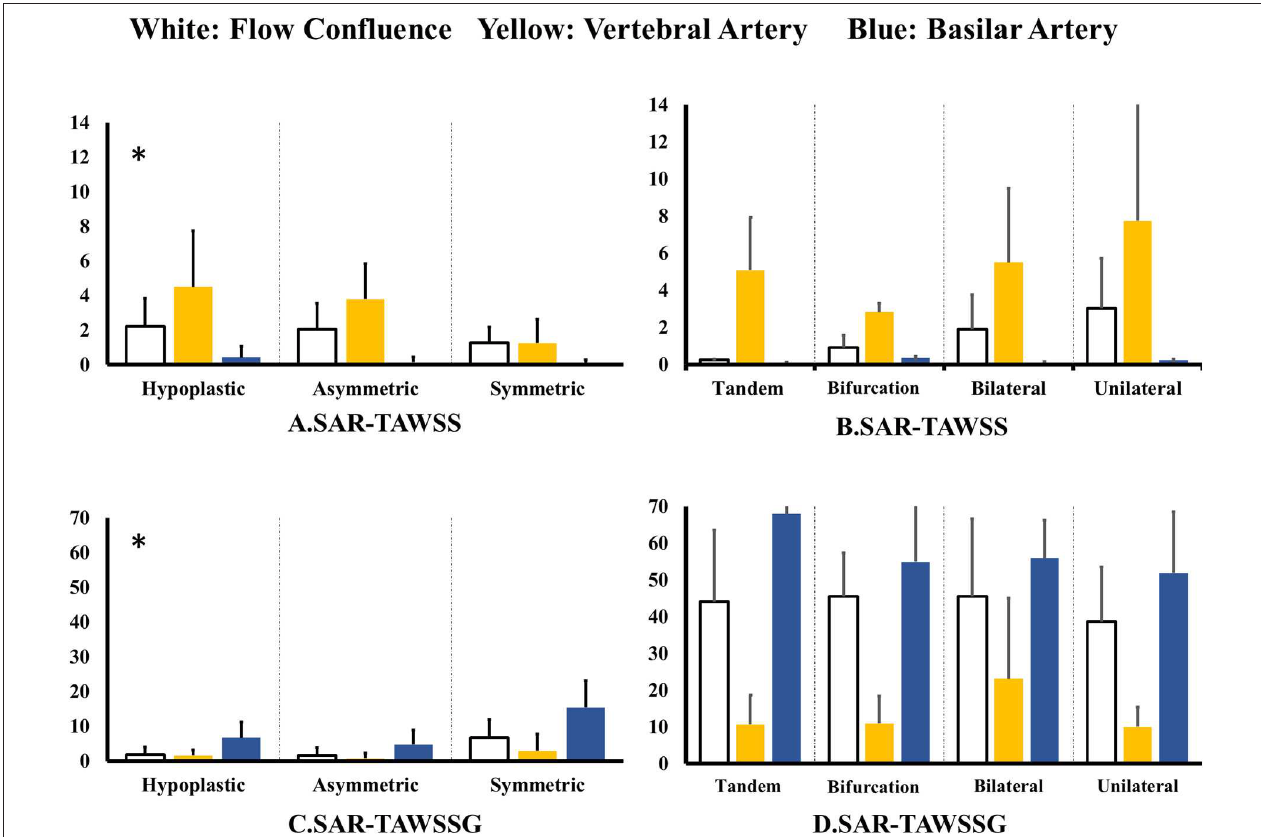
FIGURE 5 | (A,B) SAR-TAWSS within flow confluence, vertebral artery, and basilar artery in (A) symmetric, asymmetric, and hypoplastic groups and (B) unilateral, bilateral, bifurcation, and tandem stenotic sub-groups and (C,D) SAR-TAWSSG within flow confluence, vertebral artery, and basilar artery in (C) symmetric, asymmetric, and hypoplastic groups and (D) unilateral, bilateral, bifurcation, and tandem stenotic sub-groups. All patients have TIAs or posterior infarctions in the unilateral, bilateral, bifurcation, and tandem stenotic sub-groups. All patients are normal in the symmetric, asymmetric, and hypoplastic